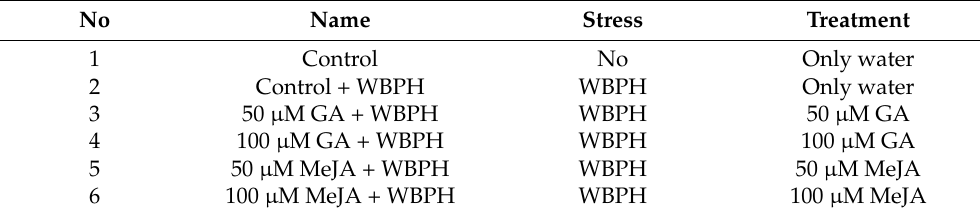
Table 2. The design of different experimental groups.